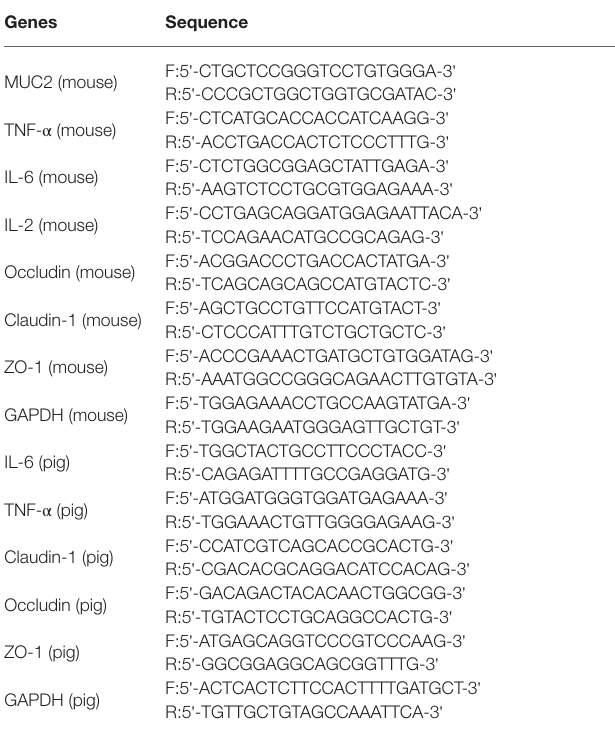
TABLE 1 | The primer sequences for real-time PCR. Genes